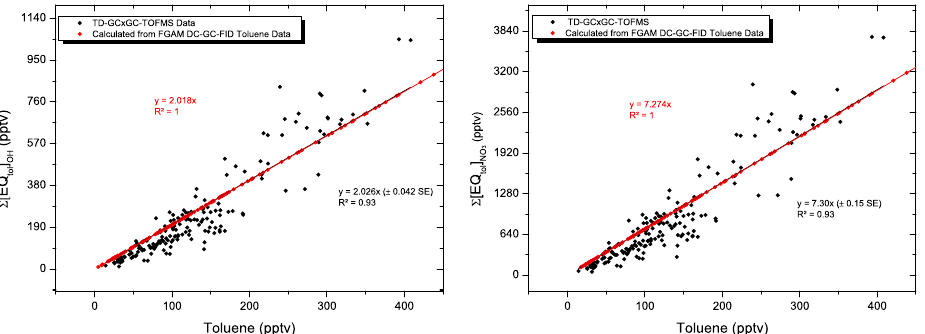
Fig. 7. Measured (black) and predicted (red) contribution to [EQ Tol ] for aromatic species measured during RONOCO. Left: Reactivity with respect to OH ([EQ Tol ] OH ). Right: Reactivity with NO 3 ([EQ Tol ] NO 3 ). The red trace corresponds to a predicted 6 [EQ Tol ] value resulting from a measured toluene mixing ratio from the GC-FID system.